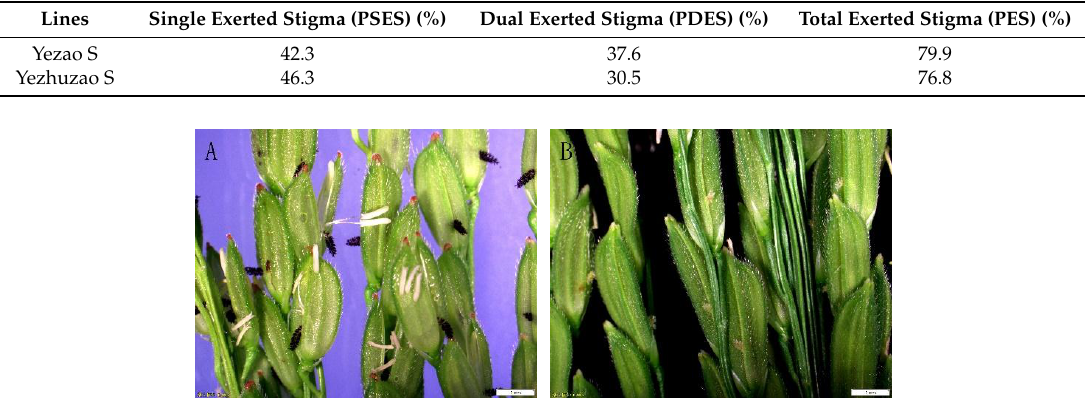
Figure 3. Comparison of stigma exsertion rate in male-sterile lines. Scale bars, 2 mm. ( A ) “Yezao S” with a black stigma; ( B ) “Yezhuzao S” with a colorless